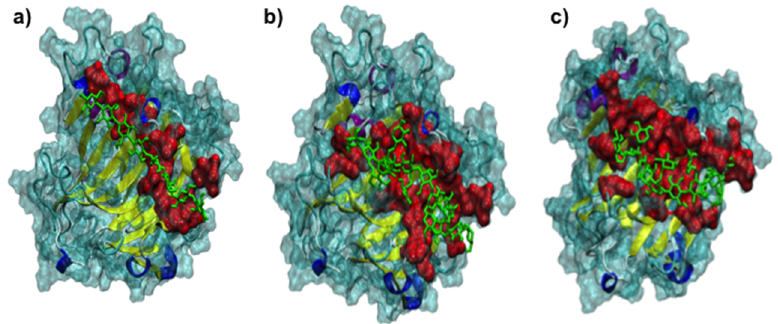
Figure 3. Protein–ligand interaction mode of FcXTH2. A general view of the position of ligands within the open groove of FcXTH2 protein model: ( a ) cellulose, ( b ) XXXGXXXG, and ( c ) XXFGXXFG. Residues involved in protein-ligand interaction in each protein are shown in red; the ligands are shown in green.